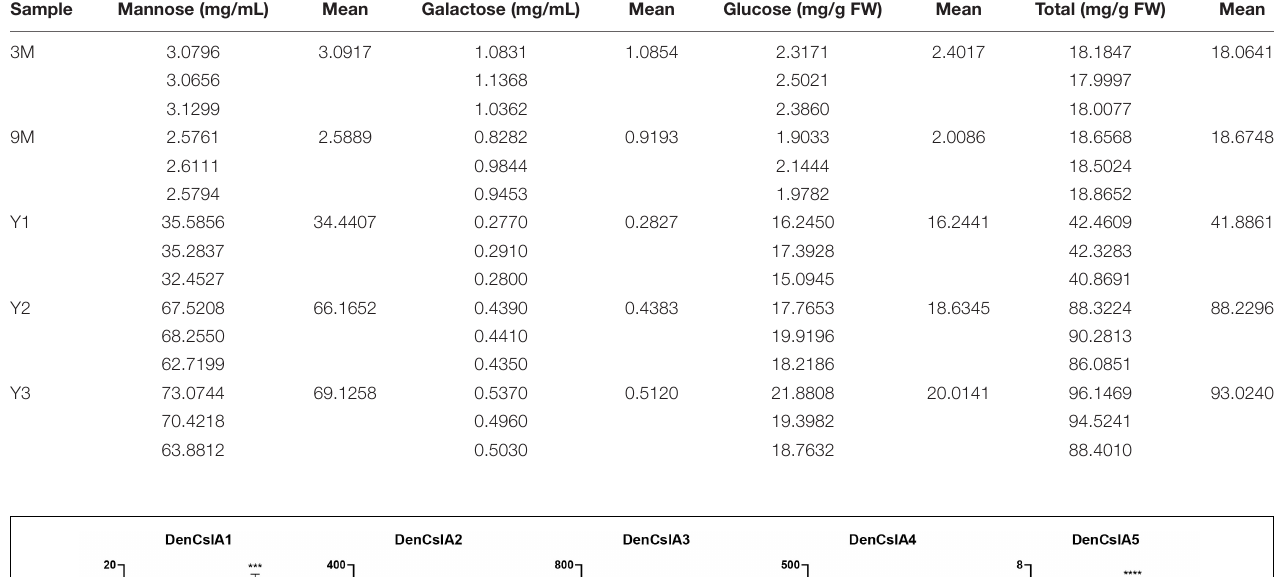
TABLE 3 | Contents of water-soluble polysaccharides and constituting monosaccharide (mg/g) in the stems of D. officinale at different growth stages, including 3M, 9M, Y1, Y2, and Y3. Sample